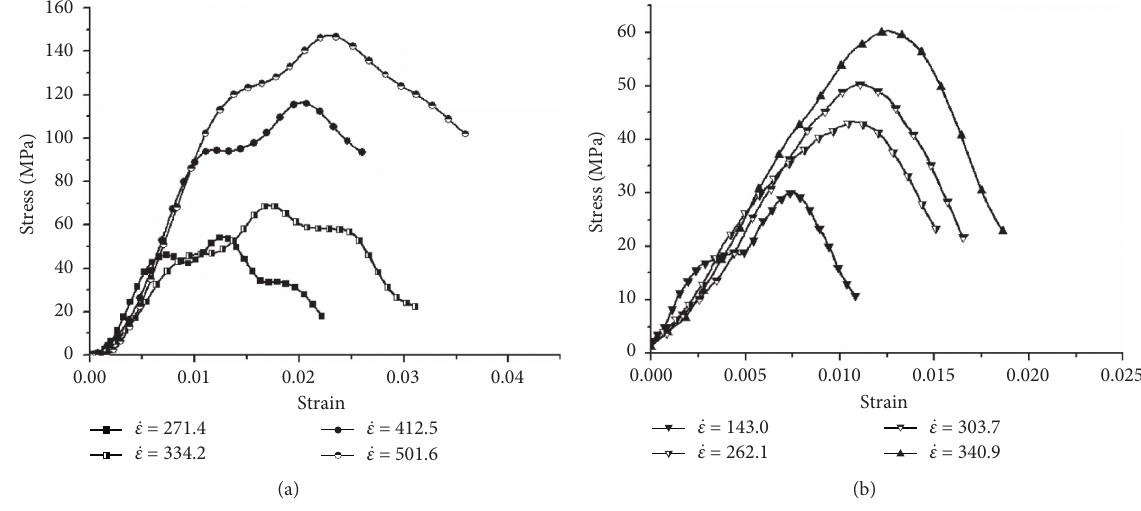
Figure 3: Stress-strain relation curves. (a) Impact compression. (b) Impact